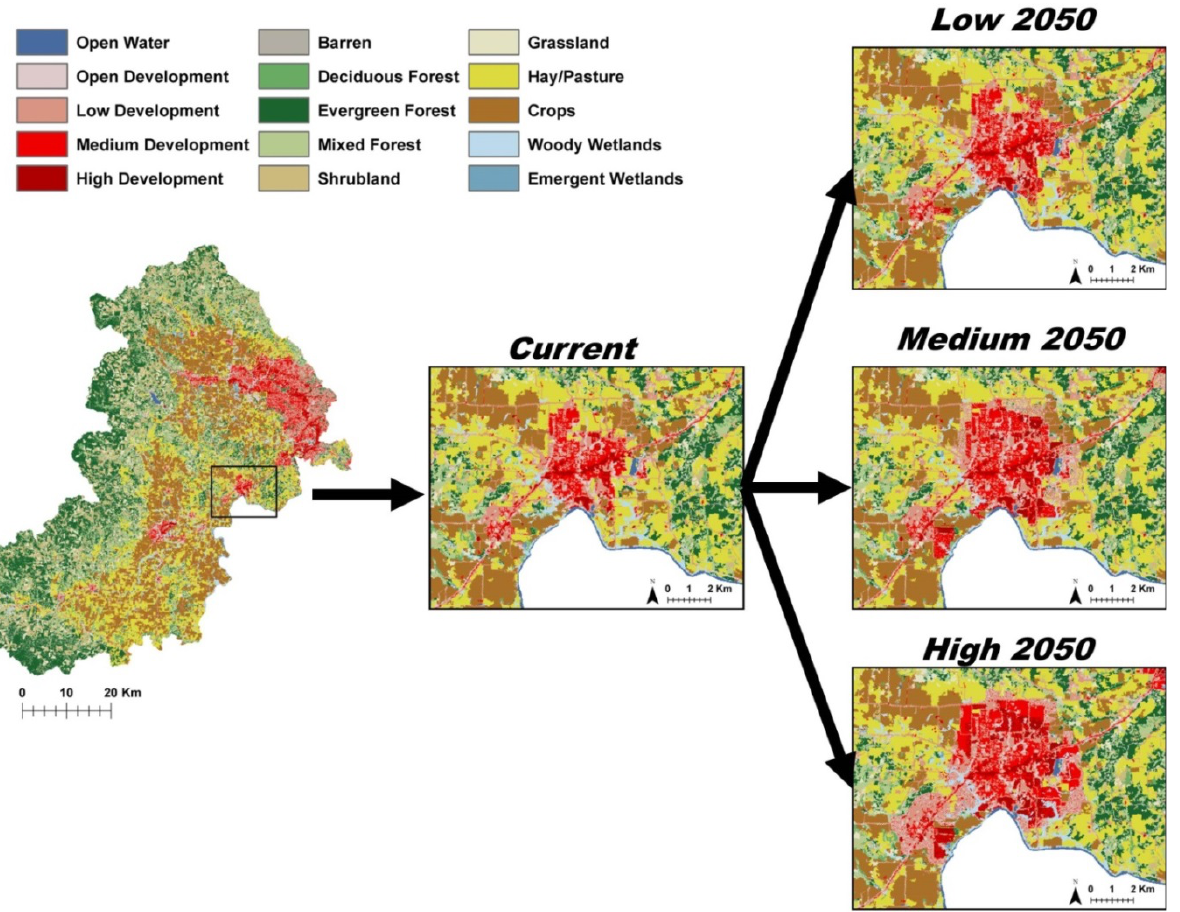
Figure 6. Inset maps of potential land cover change in the study area focusing on the area encompassing the cities of Newberg (center of inset) and Dundee (southwest